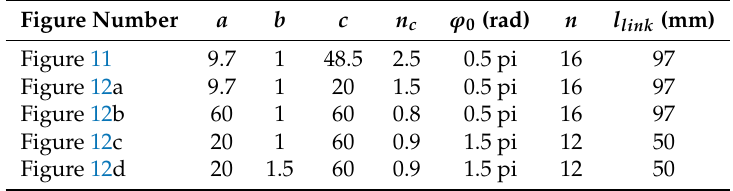
Figure 11. Head-raising motion process. Labels 1–5 show different states from initial posture to final posture of head-raising in Adams environment. Label 1 is the initial posture and label 5 is the final posture. Label 2 corresponds to the case that the robot forms a supporting configuration. Label 3 and 4 are intermediate states. The labels 6–9 are head-raising simulations of line segments model, implemented in Matlab environment. The labels 6–9 correspond to labels 1, 2, 4 and 5, respectively. Table 2. Parameters of predefined spiral curves used in head-raising simulations shown in Figures 11 and